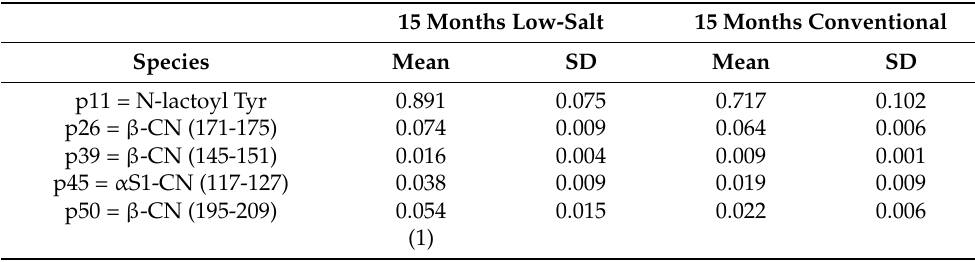
Table 3. Peptides with a significant difference between low-salt and conventional samples in 15-month-ripened cheese. Semiquantitative data, as normalized areas against the internal stan- dard phenylalanyl-phenylalanine (Phe-Phe), were considered as variables in statistical analysis and are expressed as the mean ± standard deviation over the samples of each group. Differences are significant at p <